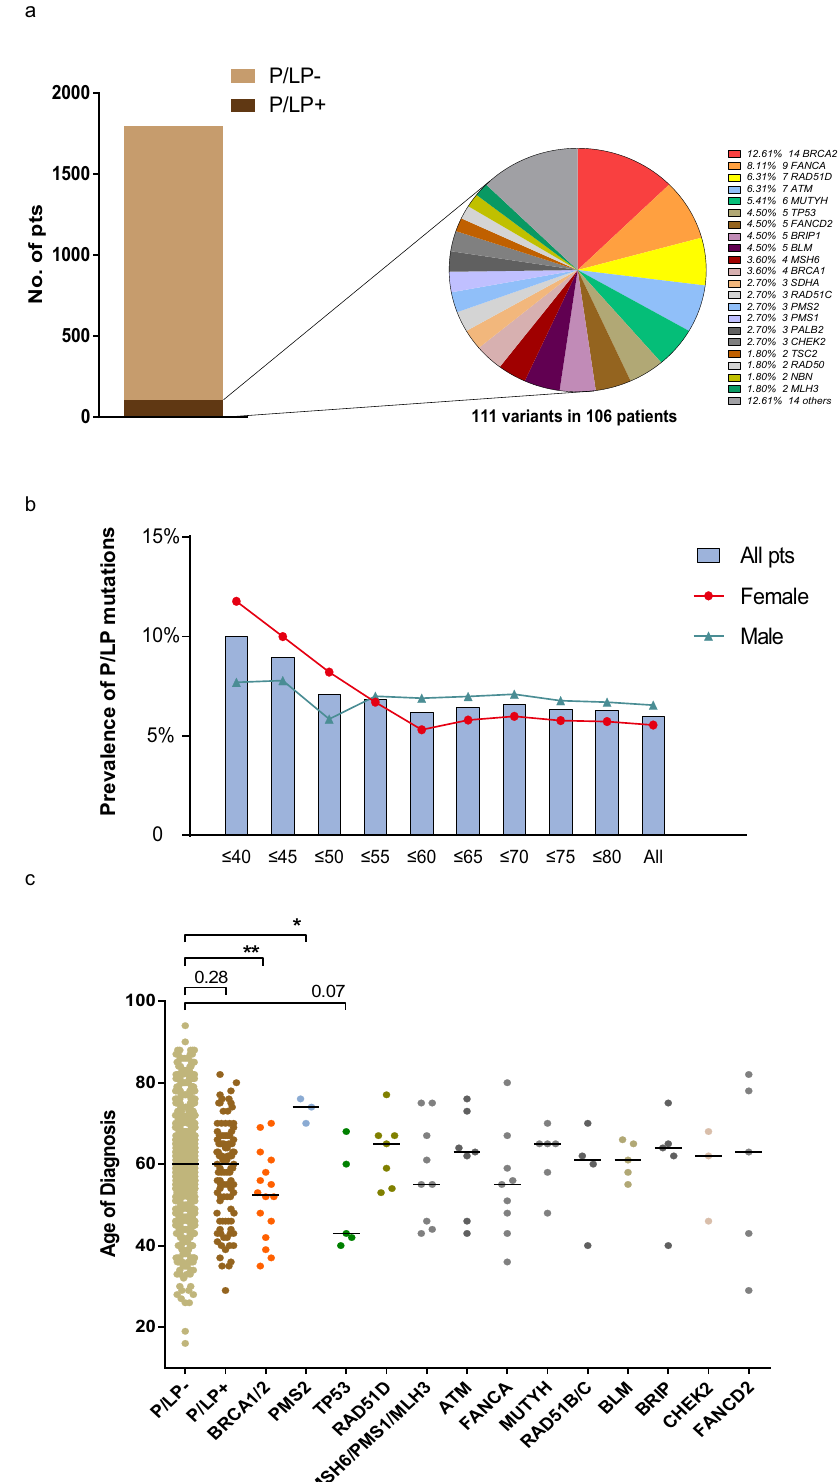
Fig. 3 Distribution of P/LP germline mutations and the age at diagnosis. a Bar plot indicated the prevalence of P/LP germline mutation (dark brown). The genes, number of patients, and mutation frequency of each gene are shown in the pie plot. Genes ( SLX4 , RUNX1 , RAD51B , RAD51 , PTCH2 , NF1 , MRE11A , GALNT12 , FLCN , FANCC , FAM175A , CDH1 , BARD1 and BAP1 ) with germline mutations detected in one patient were grouped as others. b Frequency of pathogenic and likely pathogenic germline variants in patients of different ages ( n = 1715 patients with information on age of onset). Bar plot and lines shows the frequency of germline variants in patients under certain age (bar) and frequency in female and male patients (lines). c The panels show the age of onset for patients without germline mutations ( n = 1611 patients) (light brown dots) and patients with different germline genes ( n = 104 patients) (dark brown dots). Horizontal lines indicate median age. P value is calculated by the Mann – Whitney test (* p = 0.021 , ** p = 0.008 ).